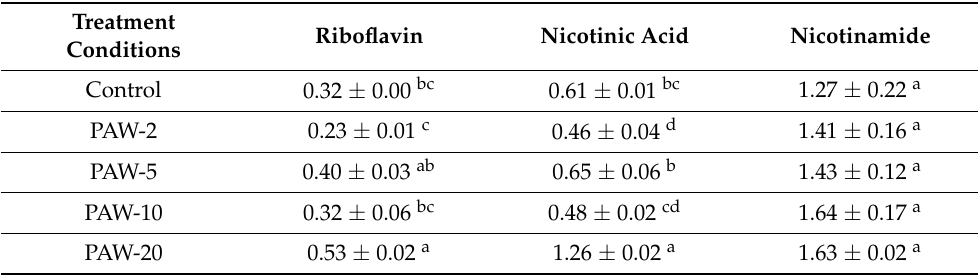
Table 3. Riboflavin, nicotinic acid and nicotinamide contents of control and PAW treated rocket samples expressed in (mg/100